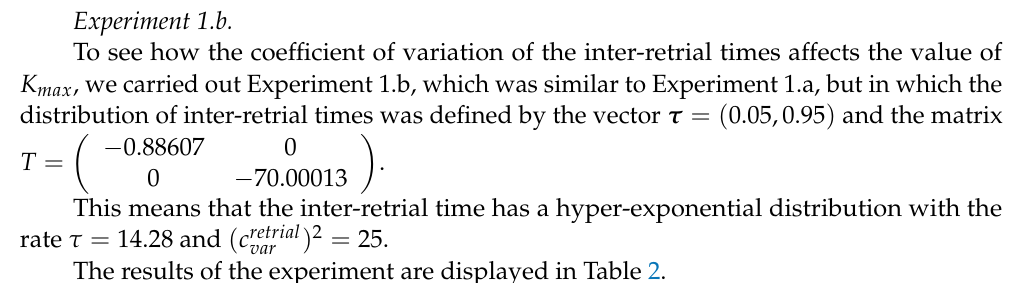
Figure 3. L vs. K for system load ρ = 0.8.